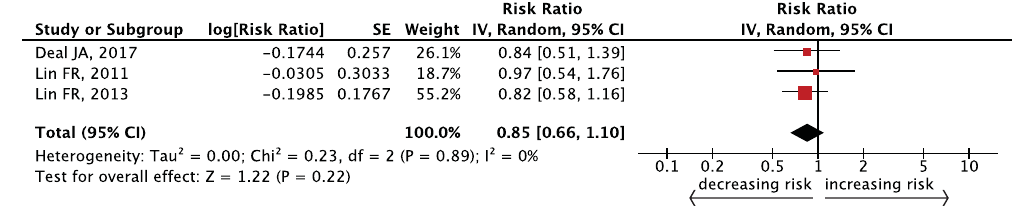
Figure 4. Forest plot showing the effect of hearing aid use on incident cognitive impairment. CI = confidence interval, IV = inverse variance, SE = standard error.